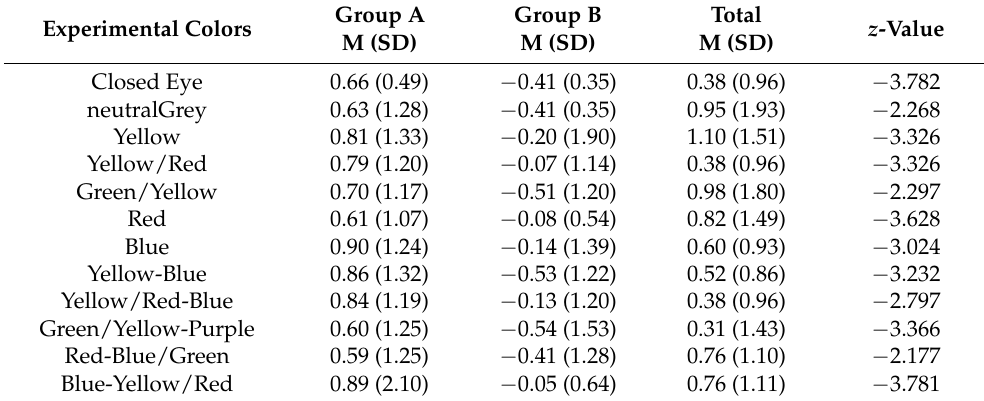
Table 5. The score of ‘Pleasure’ for color images